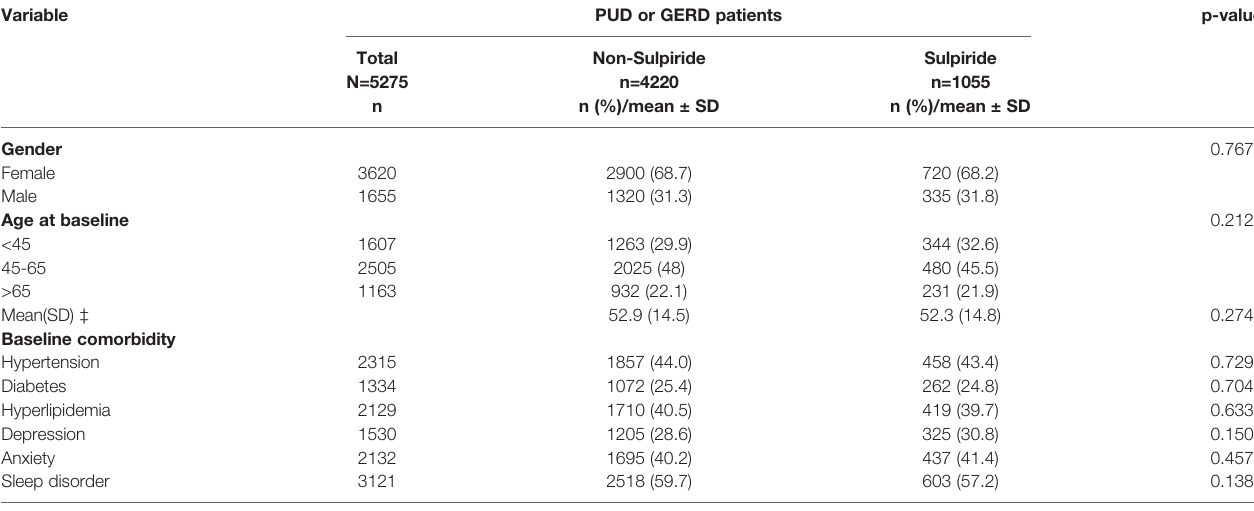
TABLE 1 | Demographic characteristics, comorbidities of PUD or GERD patients with or without sulpiride in Taiwan during 2000-2012. Variable